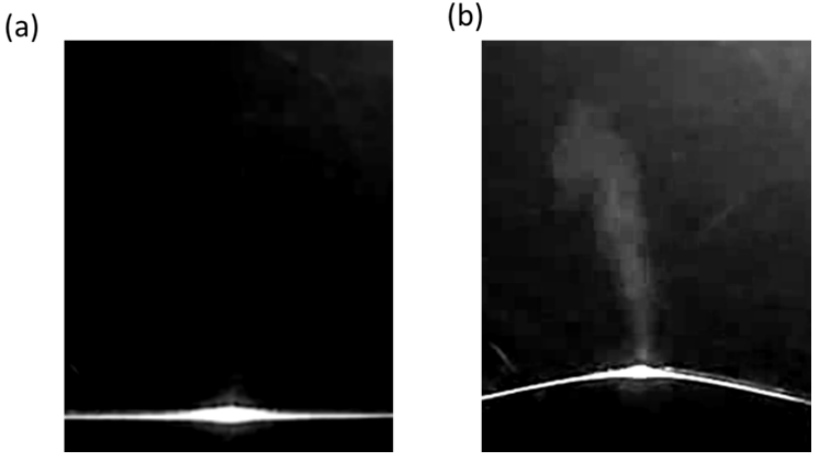
Figure 6. Comparison of plumes depending on whether or not the fine curvature is generated through the preliminary preparation process ( a ) conventional processing method, ( b ) processing method by micro curvature at 5.7 J/cm 2 100 mm/s with F-theta lens 42 R.